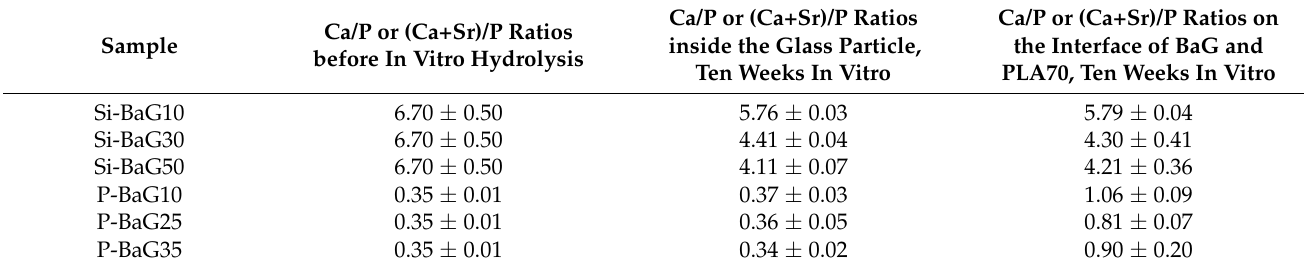
Table 4. The calculated ratios of the Si-BaG (Ca/P) and P-BaG ((Ca + Sr)/P) composites in atom % after ten weeks in vitro compared to the glass only before in vitro.